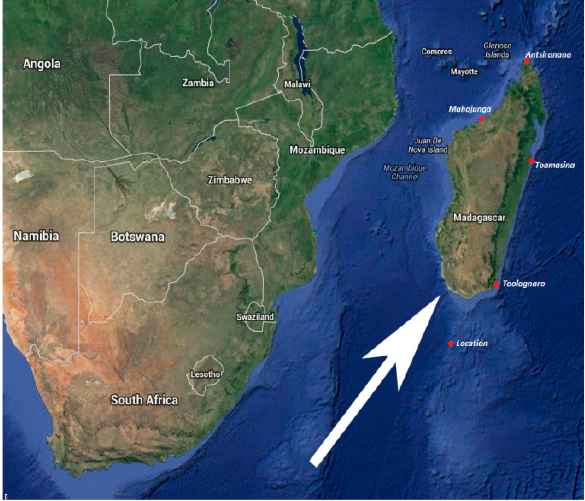
Figure 1. Madagascar map showing the four selected locations.